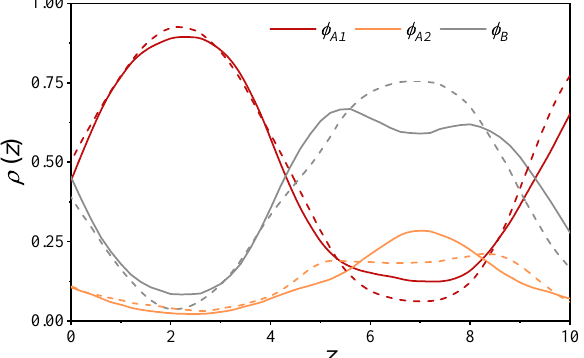
Figure 7. Lamellar ordering in the A 10 B 10 A 4 triblock copolymer: the profiles of the component volume fractions, φ A 1 ( z ) , φ A 2 ( z ) , and φ B ( z ) calculated for the two values of the Flory-Huggins parameter χ = 1.53 (solid lines) and χ = 6.12 (dashed